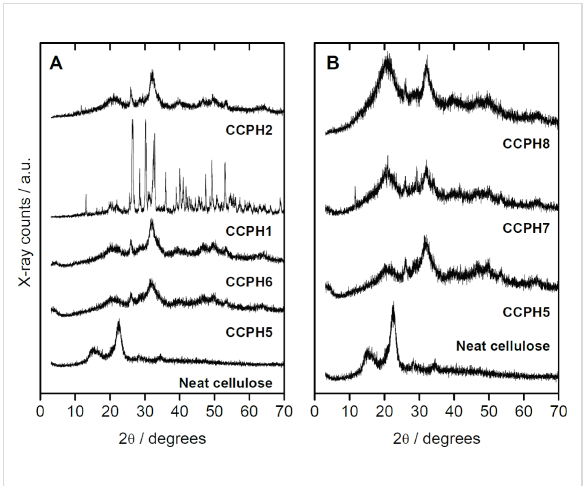
Figure 8: XRD patterns of cellulose and mineralized samples. Panel A shows effects of acid or base addition, panel B shows effects of cellu- lose concentration in the case of the samples grown with NaOH.